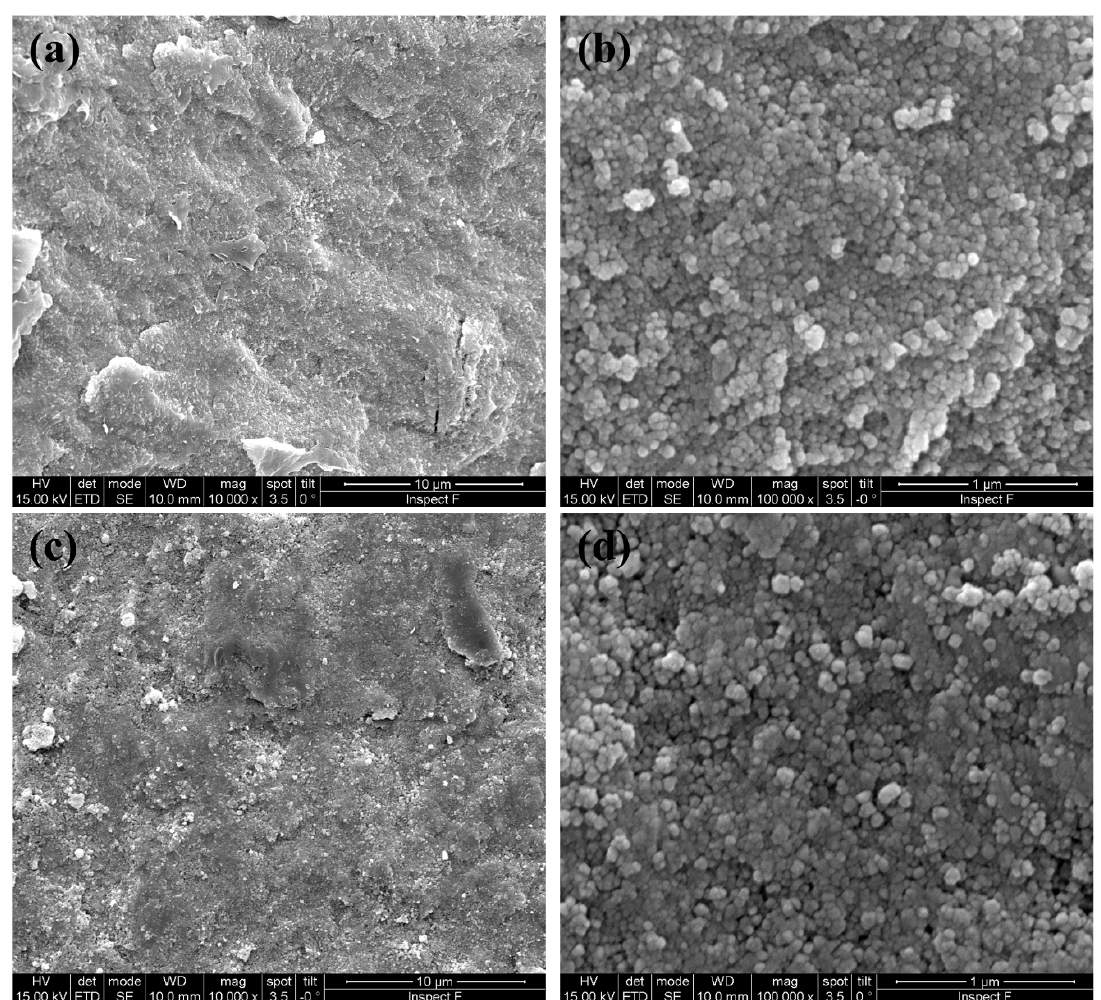
Figure 7. SEM micrographs of sintered SPDC-AC with ramp cycle; ramp up to 12 mA / mm 2 ( a , b ) and ramp up to 18 mA / mm 2 ( c , d ).